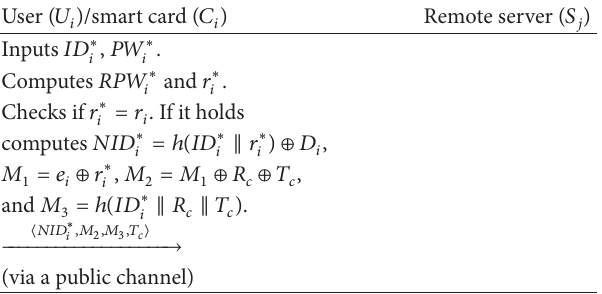
Table 2: Summary of the login phase of our